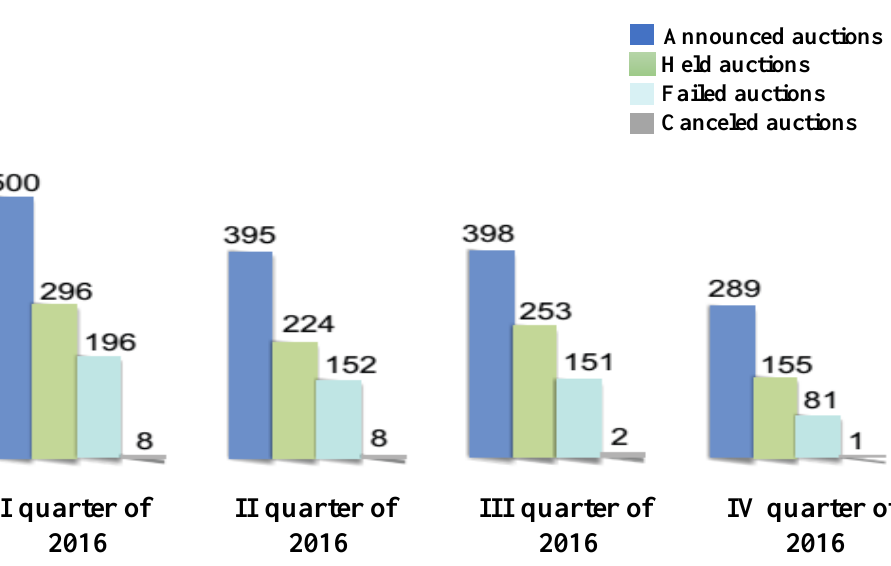
Fig. 1. Auctions announced in 2016 (National Agency of State Property, n. d.).